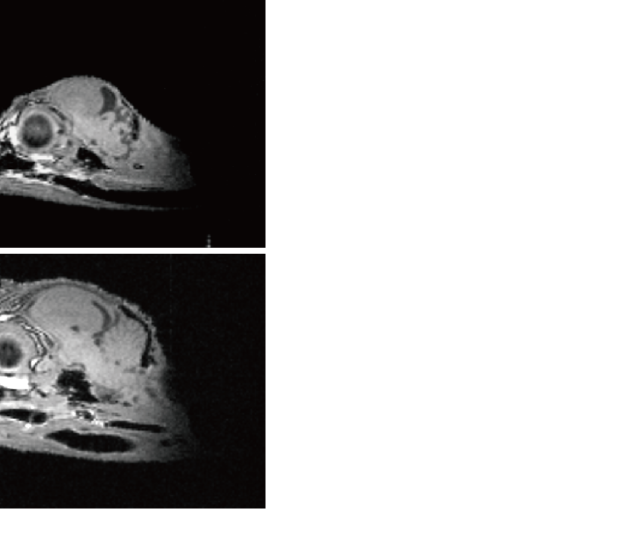
Fig 1. MRI images acquired by μ MRI, MRmini SA (MRTechnology,